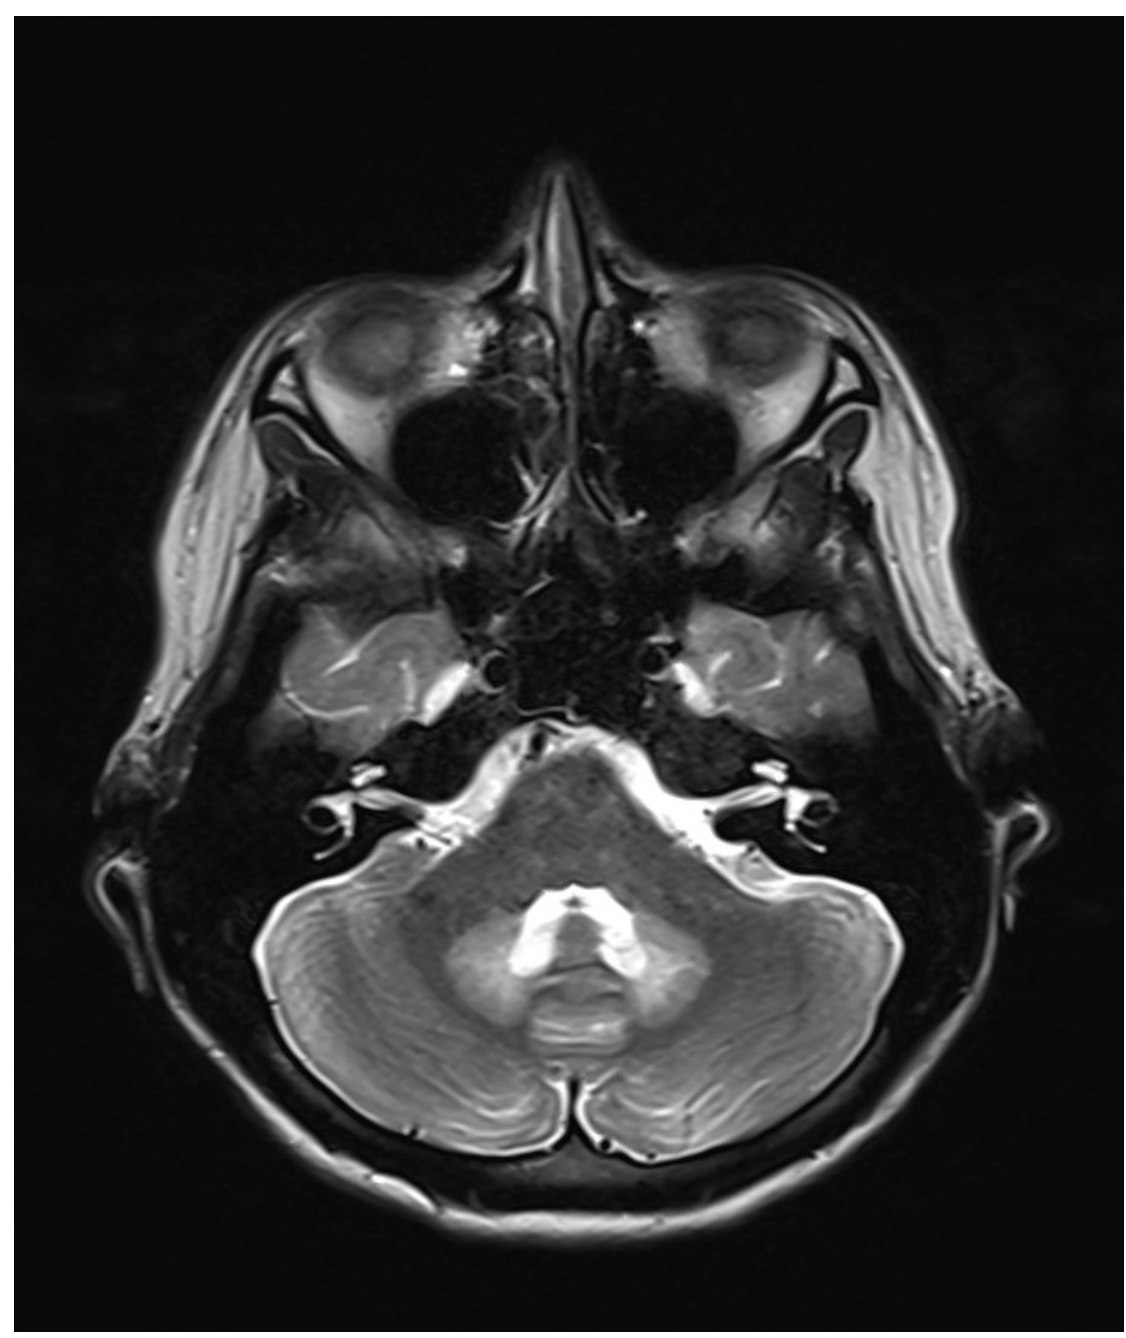
Figure 1. T2-weighted MRI axial view showing signal hyperintensity within dentate nuclei.